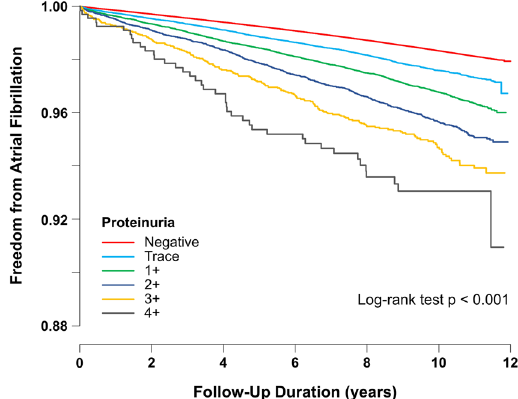
Figure 1. Kaplan-Meier survival curves for freedom from atrial fibrillation. Subjects with higher levels of proteinuria were associated with a higher risk of atrial fibrillation during the follow-up period than those with lower levels of proteinuria.